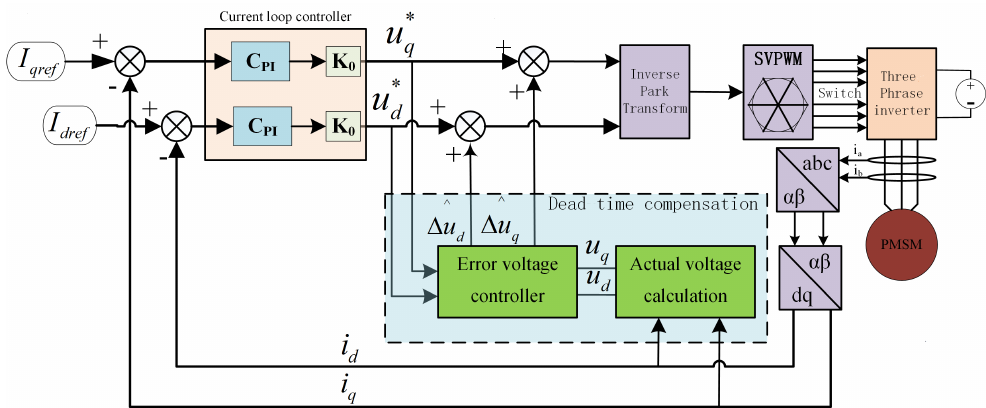
Figure 3. Block diagram of the system control.